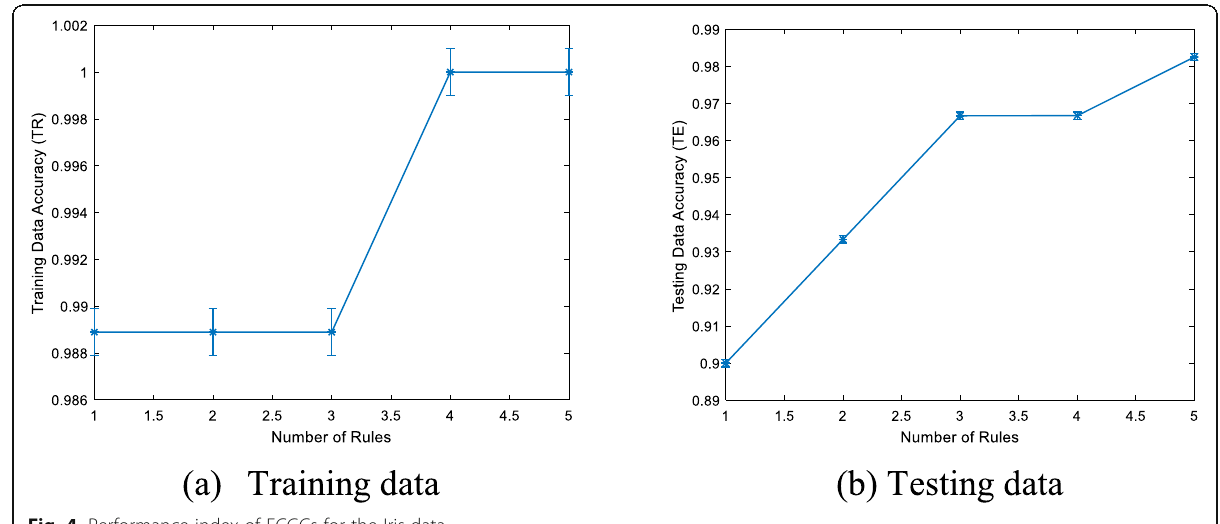
Fig. 4. Performance index of ECGCs for the Iris data